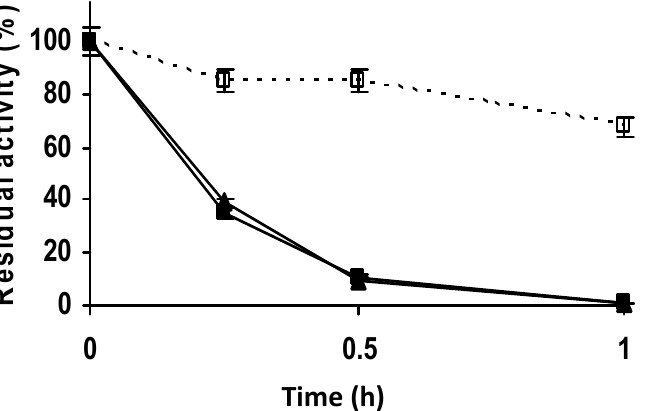
Figure 7. Thermal inactivation of r Aae UPO immobilized on amino-glutaraldehyde support com- pared to the free enzyme. The inactivation was performed in 10 mM Tris at pH 7.0 and 57 °C. Other specifications can be found in the Methods section. Full triangles: biocatalyst immobilized at pH 5.0; full squares: biocatalyst immobilized at pH 7.0; empty squares with dotted line: free en- zyme.